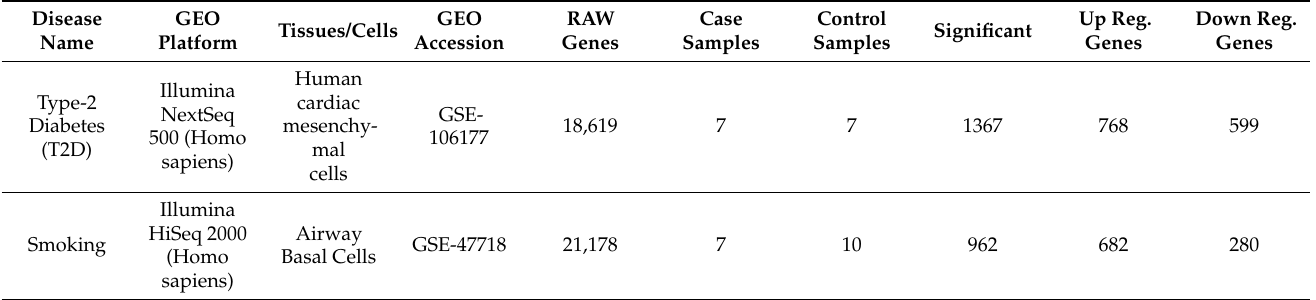
Table 1. An overview of the data and findings from the transcriptome study. It includes the dataset accession number, sample source, total raw genes, sample number, significant